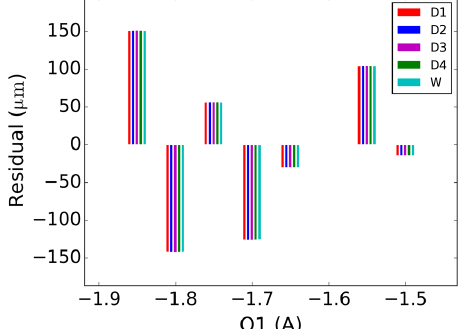
FIG. 10. Residuals for the fits with only the RFD phase jitter. The residual is defined as the difference between the predicted value and the data.